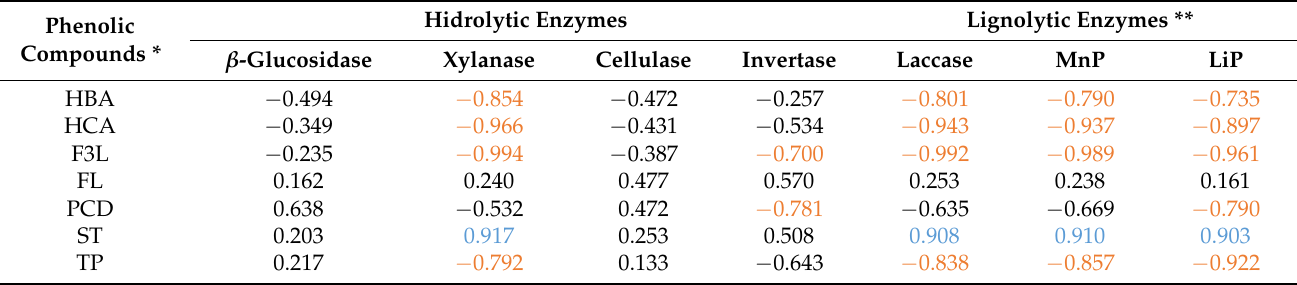
Table 8. Correlation coefficient ( r ) between the concentration of certain groups of phenolic compounds and the activity of hydrolytic and lignolytic enzymes in GP after SSF with R. oryzae in tray bioreactor.